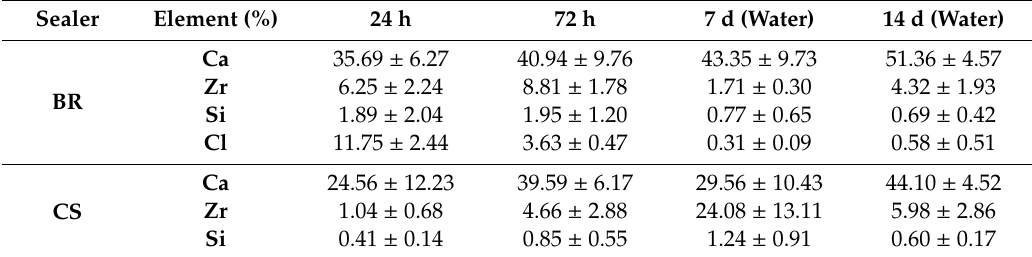
Table 4. The mass percentages of the main element compounds of BioRoot and Ceraseal surfaces in 95% humidity after 24 and 72 h, 7 and 14 d in water at 37 ◦ C.